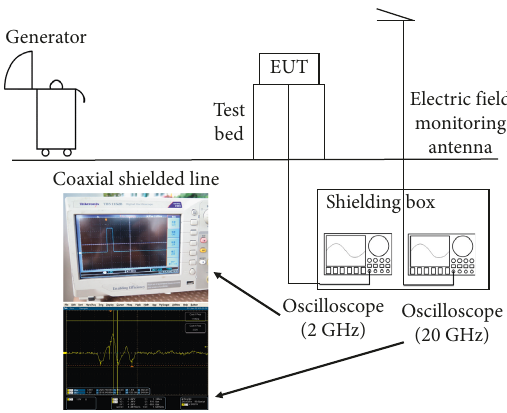
Figure 1: Basic setup of the test facility.